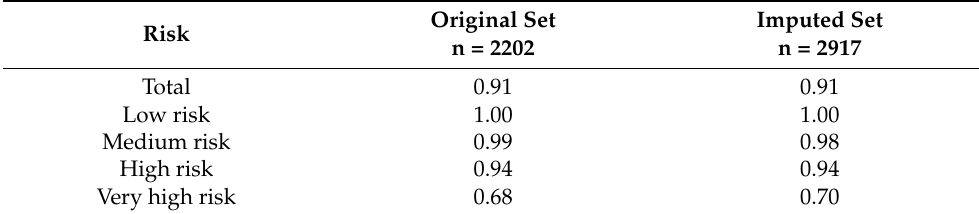
Table 4. Five year relative survival by risk before and after multiple imputation.